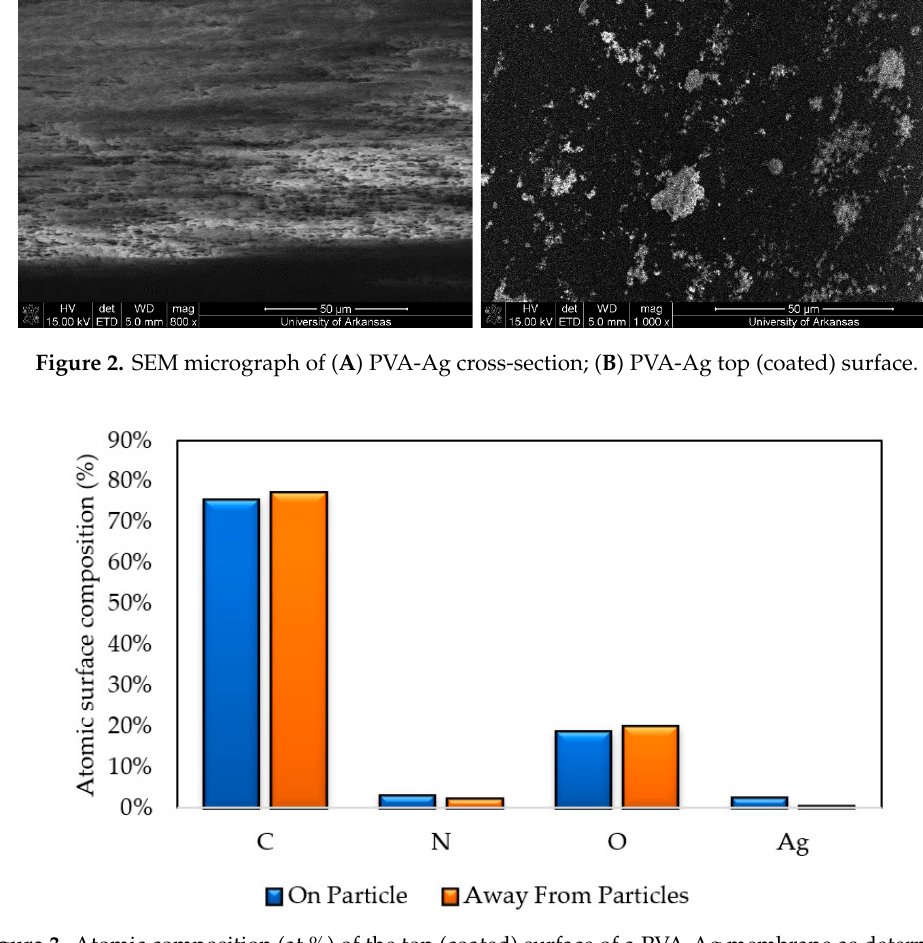
Figure 3. Atomic composition (at %) of the top (coated) surface of a PVA-Ag membrane as determined by EDS.